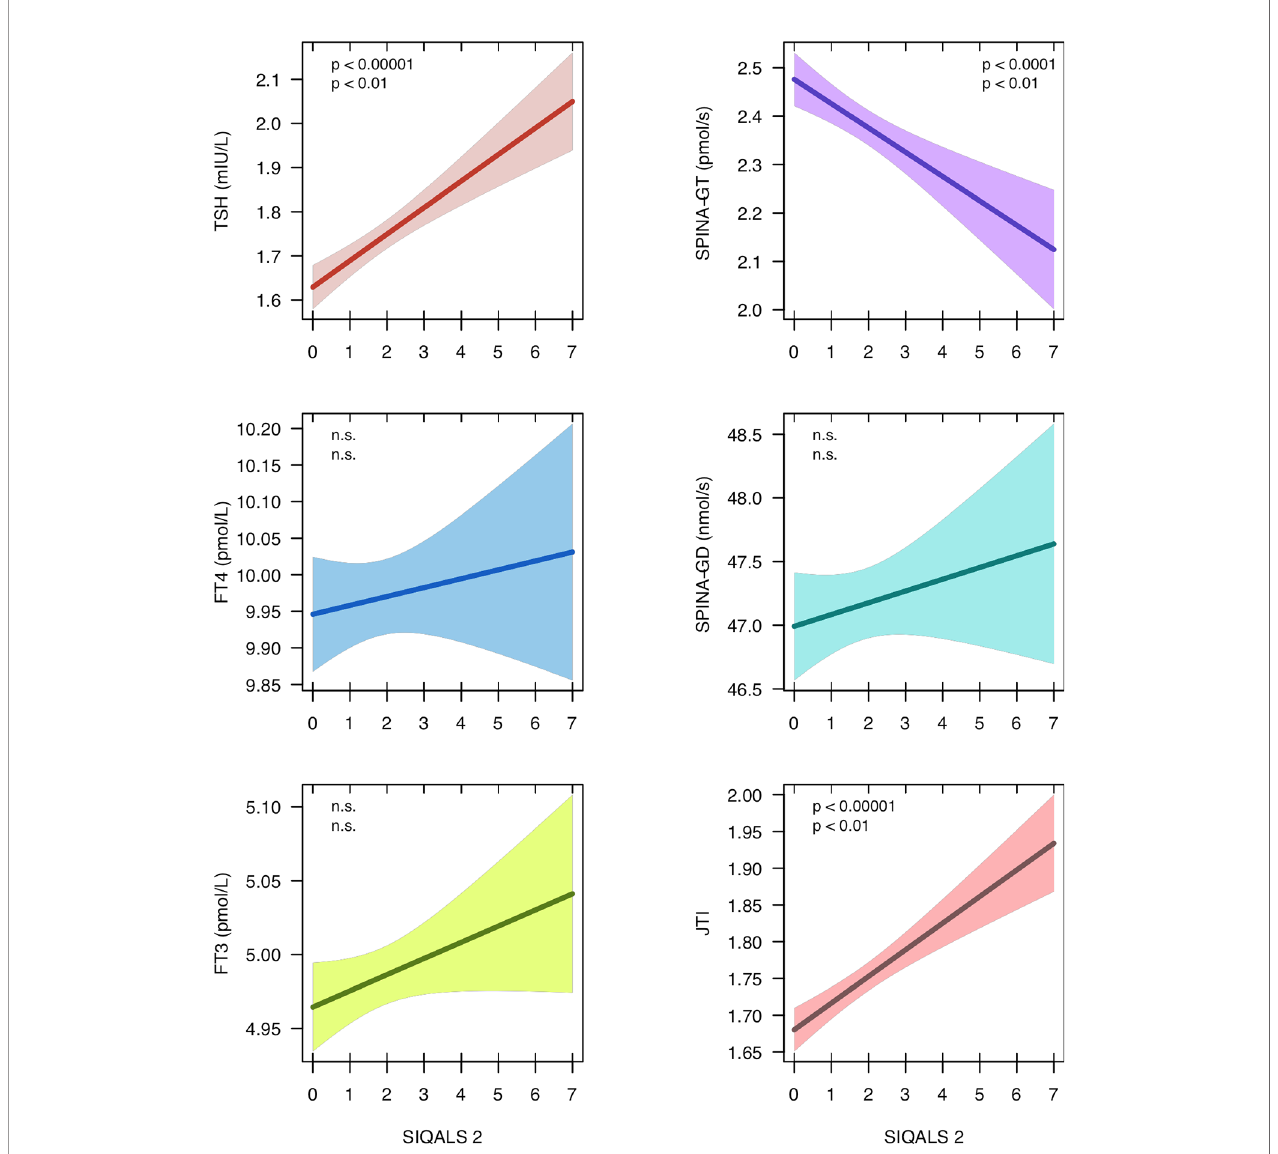
FIGURE 2 | Regression models between type 2 allostatic load (SIQALS 2) and parameters of thyroid homeostasis in 3386 euthyroid subjects. Data were obtained from the National Health and Nutrition Examination Survey (NHANES), 2007 to 2008 (40). Shown is the regression line with 95% con fi dence bands. In each panel, the fi rst p value refers to unadjusted OLS regression and the second p value to estimates derived from instrumental variable (IV) regression. For regression details, see Supplementary Tables 2 and 6